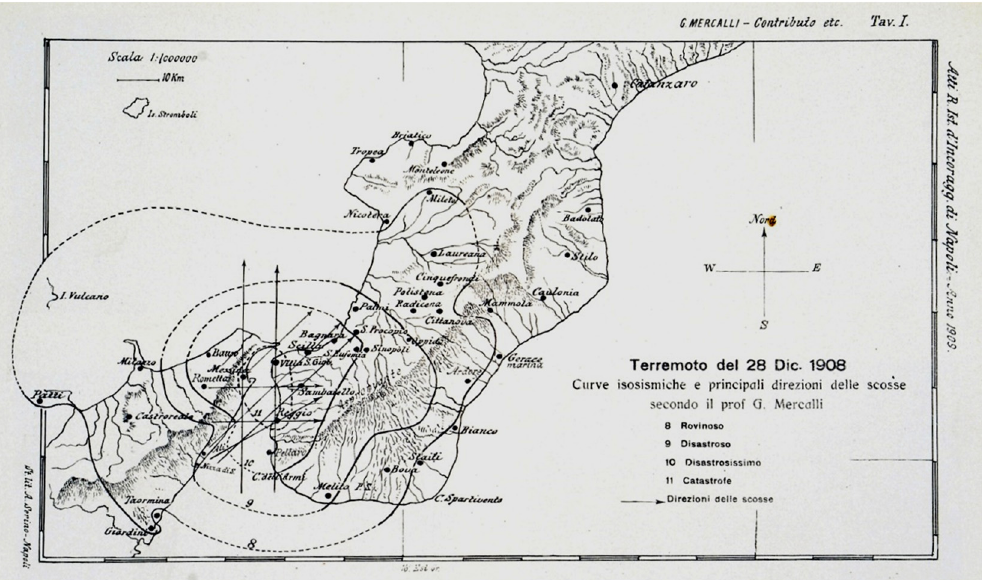
Figure 2. Intensity pattern of the 1908 earthquake (after Mercalli, [16]). The dashed area suffered the strongest ground shaking.